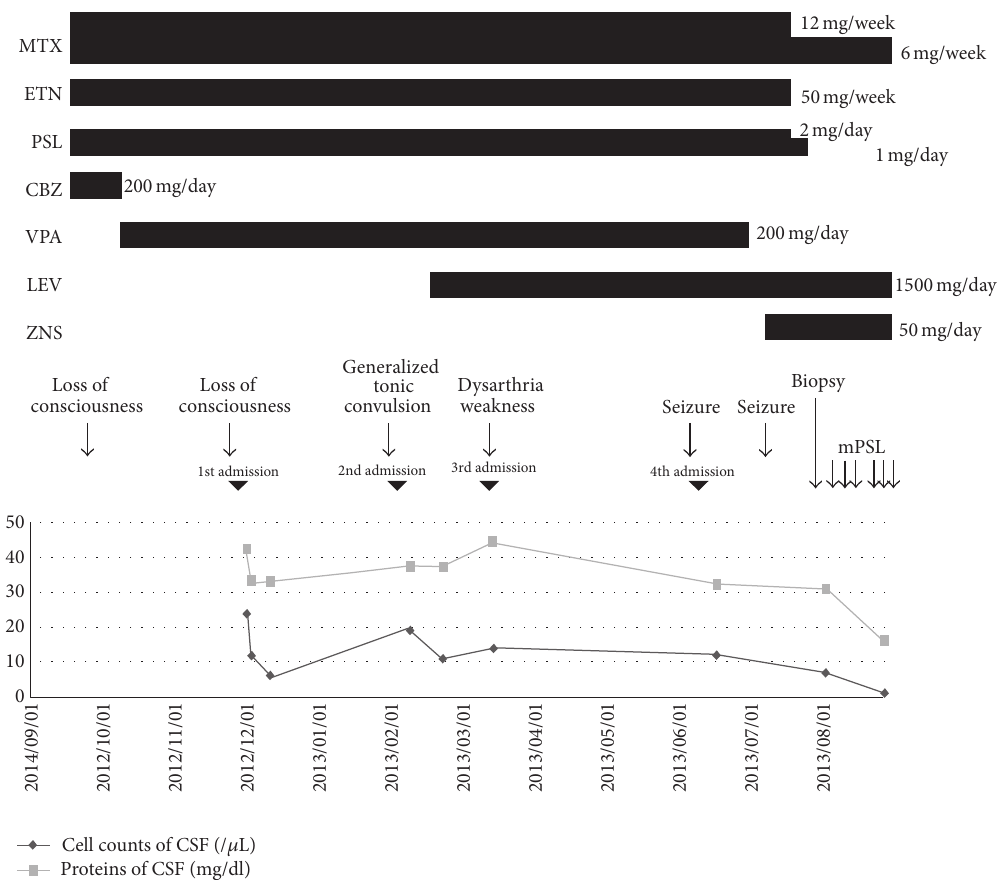
Figure 1: Clinical course. After the treatment with intravenous methylprednisolone, cell counts and proteins of CSF decreased, and seizures disappeared. MTX: methotrexate, ETN: etanercept, PSL: prednisolone, CBZ: carbamazepine, VPA: sodium valproate, LEV: levetiracetam, ZNS: zonisamide, and mPSL: